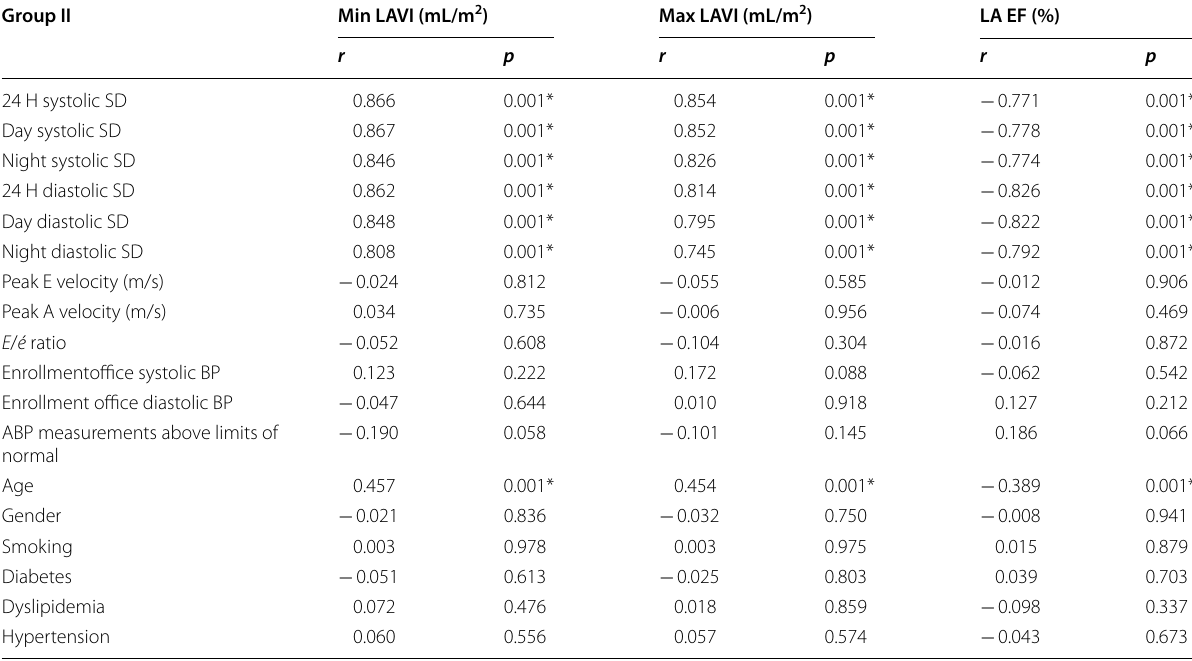
Table 5 Correlation between echocardiographic parameters and the demographic data in Group